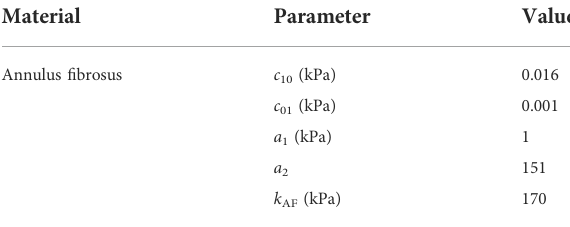
TABLE 3 Material model parameters of the AF obtained through inverse FEM and with the experimental results published in Widmer et al.